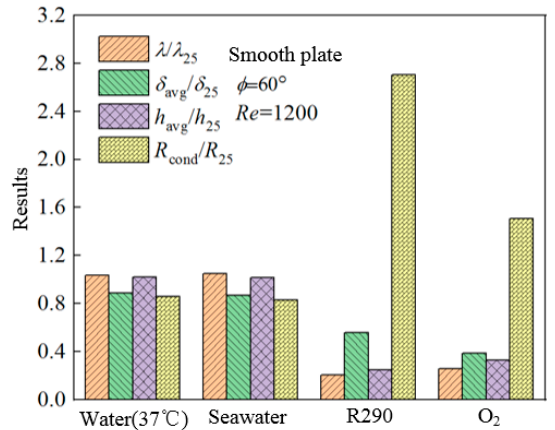
Figure 4. Dimensionless results for different fluids on the smooth plate.